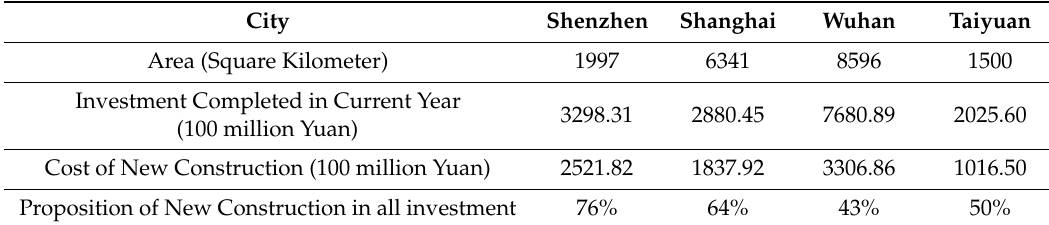
Table 6. Index of urban construction in the four experimental cities.